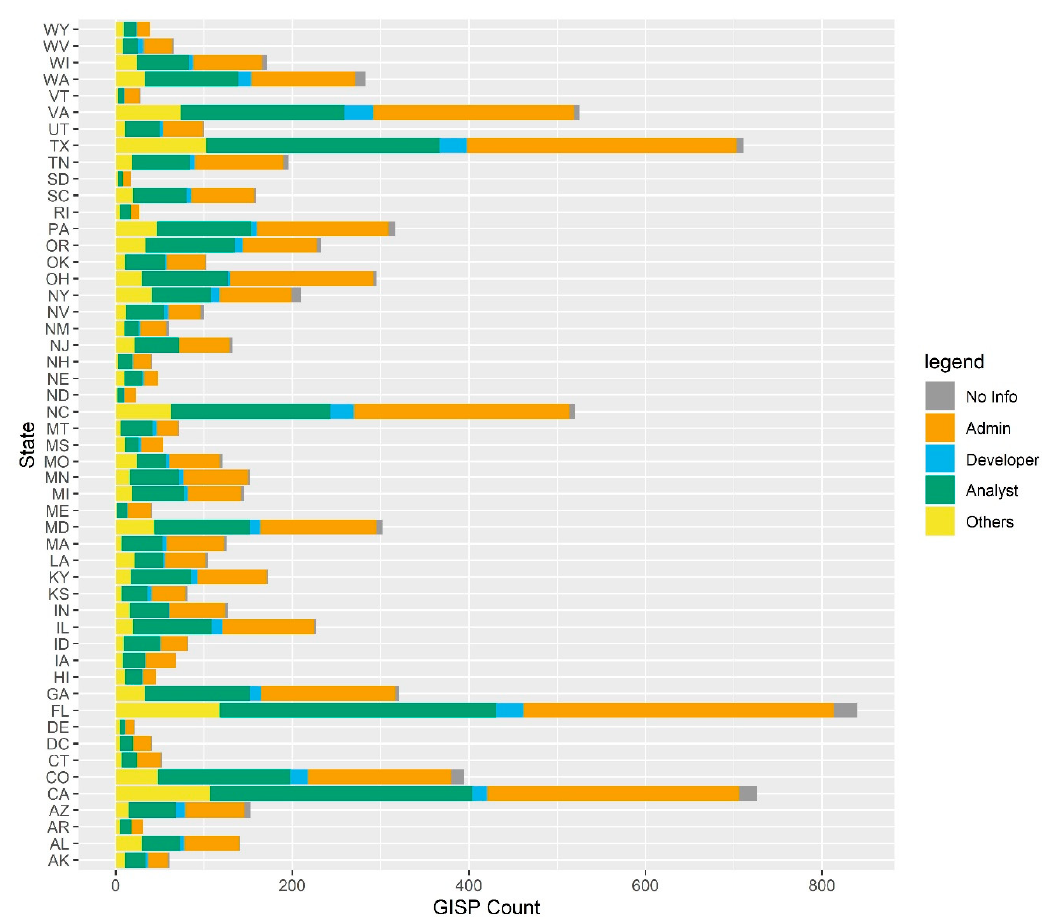
Figure 7. The number of GISPs with different job titles in each state.